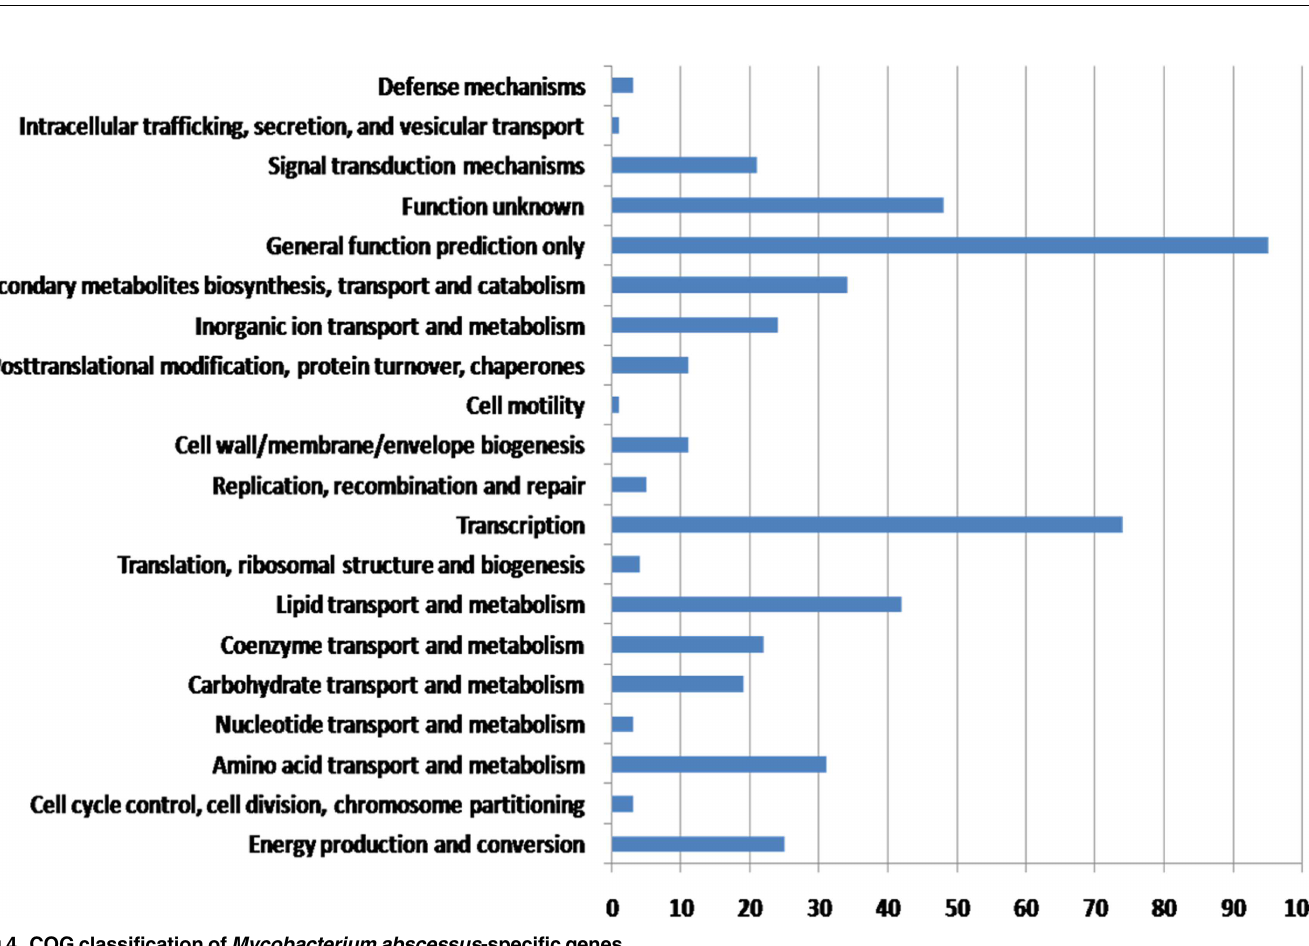
Fig 4. COG classification of Mycobacterium abscessus